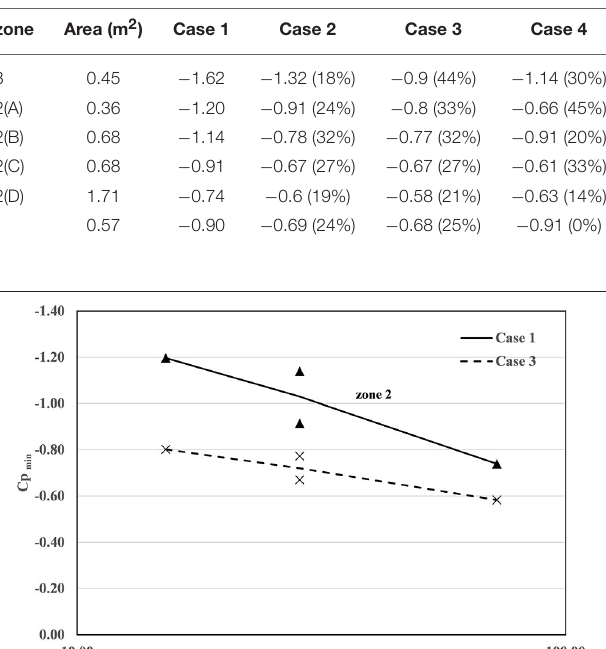
TABLE 3 | Area averaged C p min, 3s (worst case) values for different test configurations.